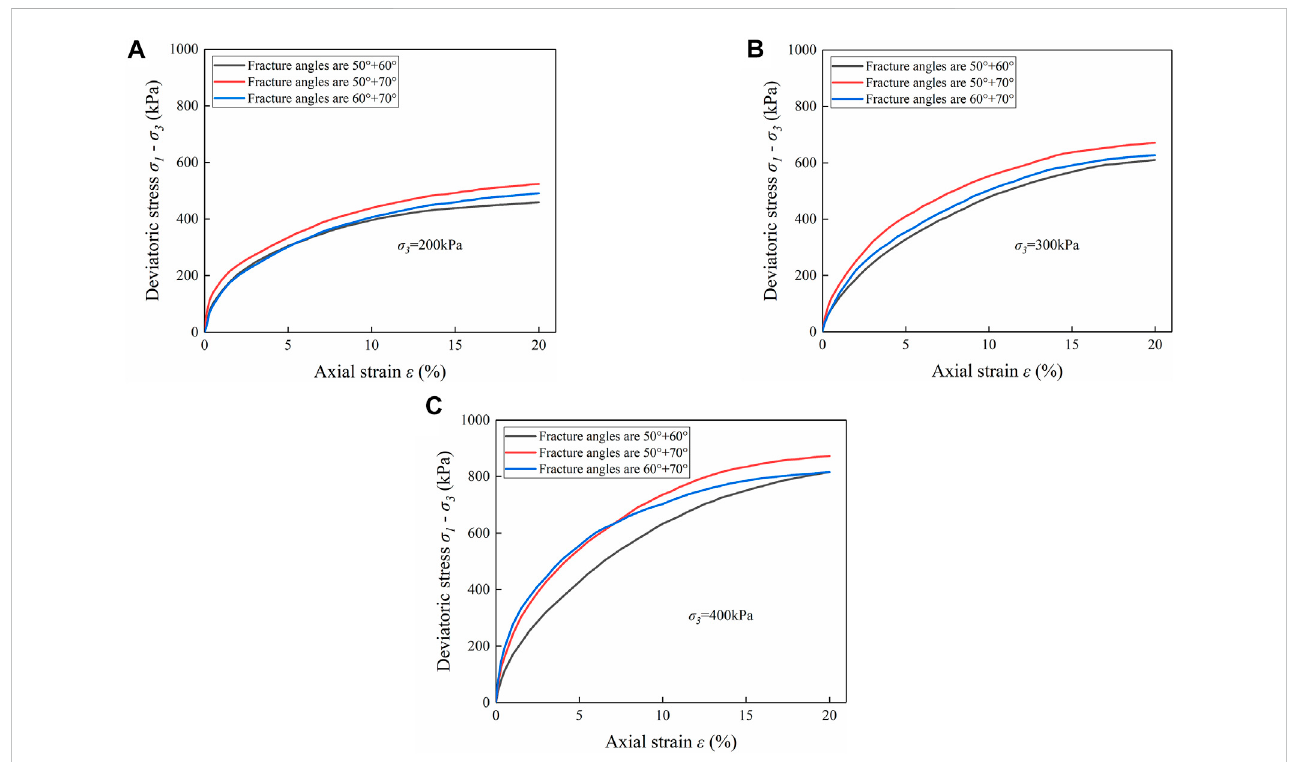
FIGURE 6 Deviator stress versus axial strain of loess with different composite fracture: (A) σ 3 =200 kPa; (B) σ 3 =300 kPa; (C) σ 3 =400 kPa.